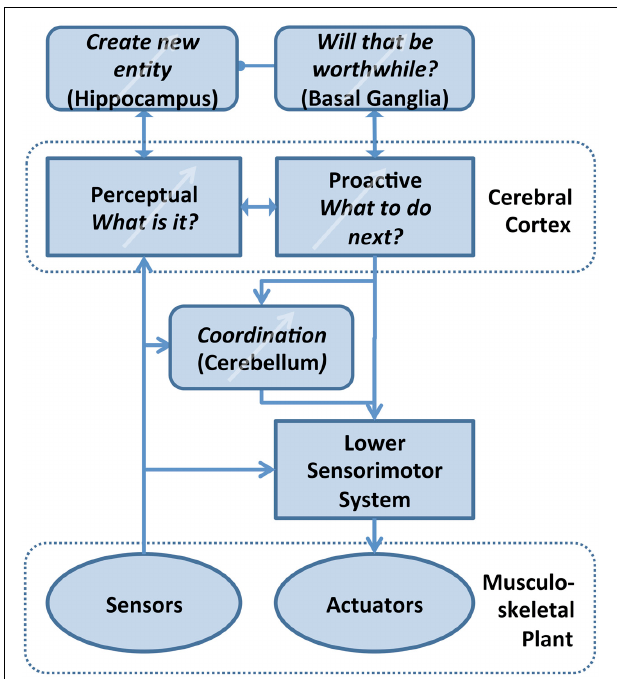
FIGURE 5 | Theory of computation for Bayesian Action&Perception. The associative memory in the various areas of cerebral cortex interprets incoming sensory data in the light of current hypotheses about the potential identity of objects (Perceptual) and selects an output that it expects will confirm that hypothesis by generating new sensory data (Proactive). Orderly development, use and refinement of this cortical database requires three major supporting functions that also require some form of learning: Value judgments are required to decide what level of certainty is acceptable for the identity and expected behavior of an unknown object, tentatively ascribed to the basal ganglia (Bornstein and Daw, 2011). If no acceptable identification is possible, then these unreconciled associations of motor strategies and sensory feedback that have been experienced with the unknown object must be remembered and eventually turned into a compressed, efficient representation of a new entity in cerebral cortex, tentatively ascribed to hippocampus (Winocur et al., 2010; Petrantonakis and Poirazi, 2014). The learned, abstract motor strategies need to be coordinated with lower level sensorimotor systems (e.g., spinal cord and brainstem) that can activate and stabilize complex body movements, tentatively ascribed to cerebellum (Thach,